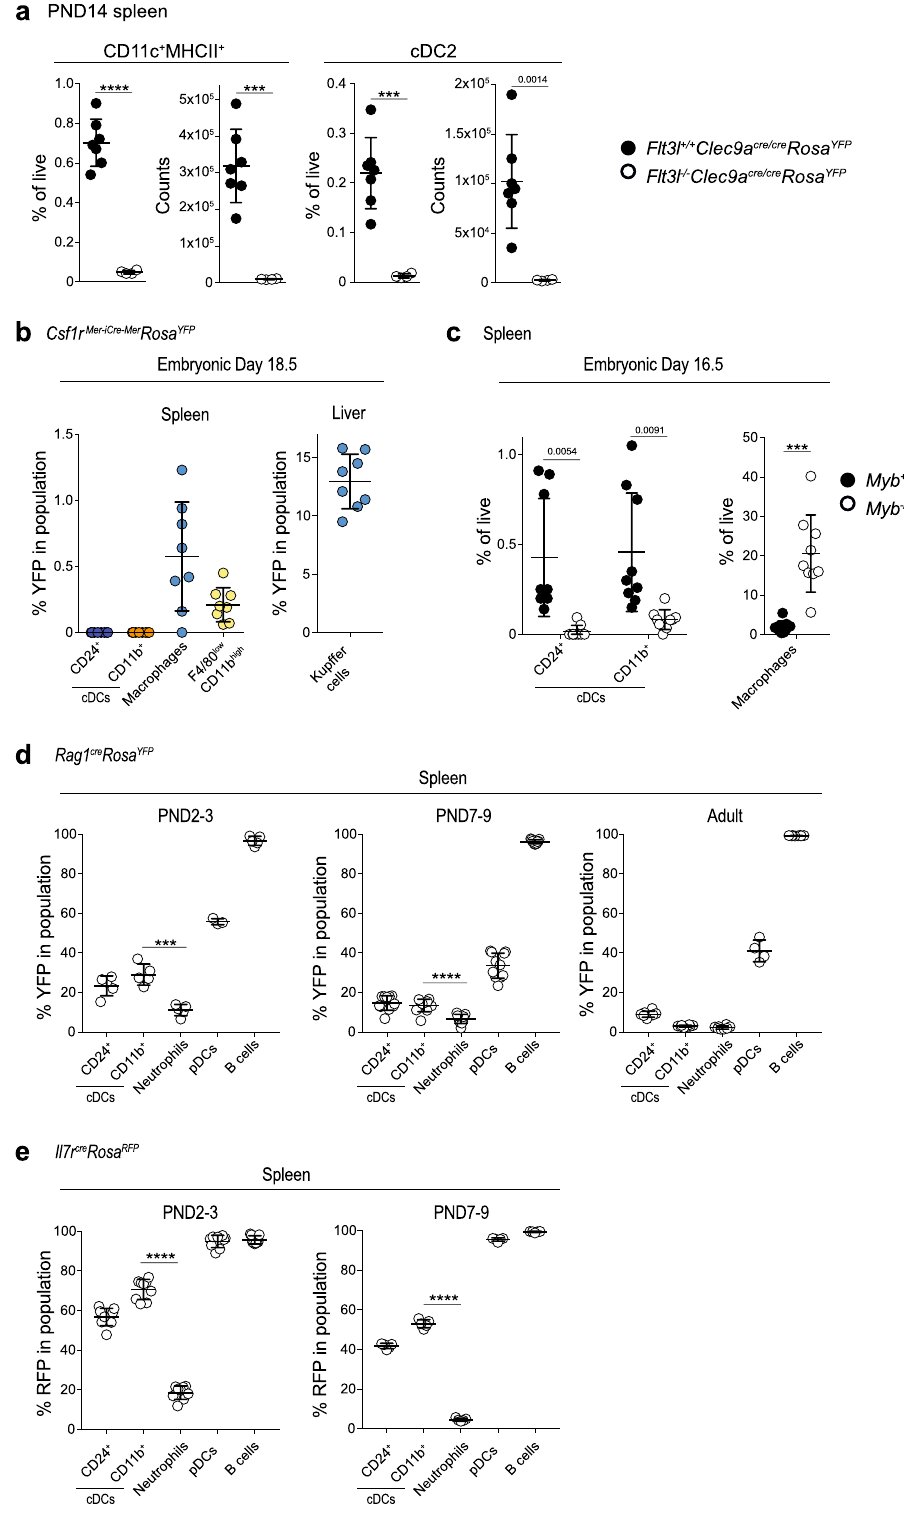
development of de fi nitive HSCs 68 . Myb -de fi cient mice are embryonically lethal but survive until E16.5. At this time CD24 + and CD11b + cDCs, but not splenic macrophages, were reduced in spleens from Myb − / − compared to littermate control embryos (Fig. 2c). Thus, CD11c + MHCII + cells arise independent of yolk